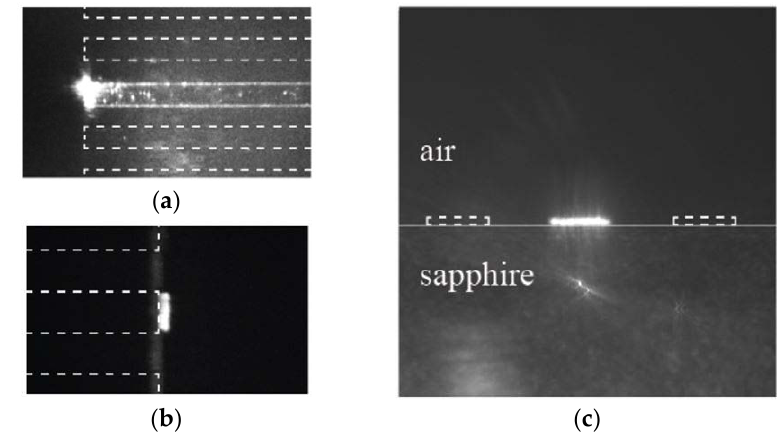
Figure 3. Light propagation observed by CCD camera 1, shown in Figure 2b, mounted above the sample: ( a ) At in-coupling and ( b ) out-coupling positions. ( c ) Out-coupling recorded by CCD camera 2, shown in Figure 2b. White dashed lines represent waveguide positions where they are not easily seen. Note that all waveguides have a stripe width of 10 μ m.